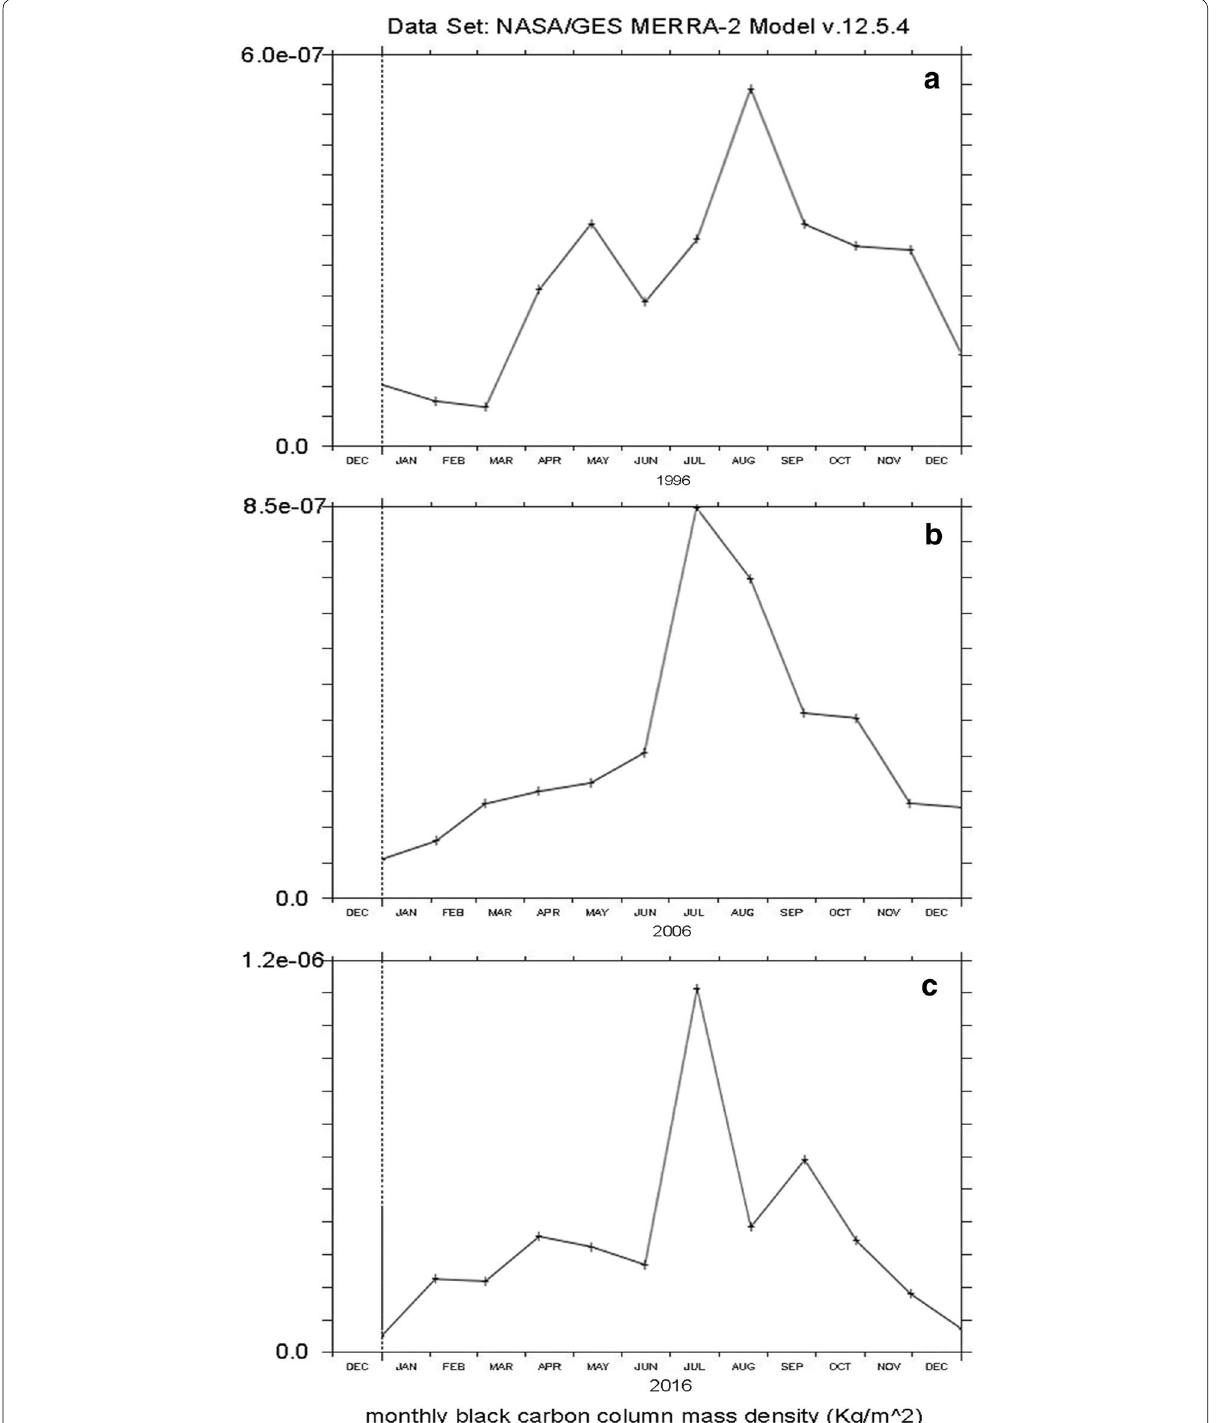
Fig. 3 Monthly black carbon column mass density extracted from NASA/GES MERRA-2 model for three time windows a 1996, b 2006, and c